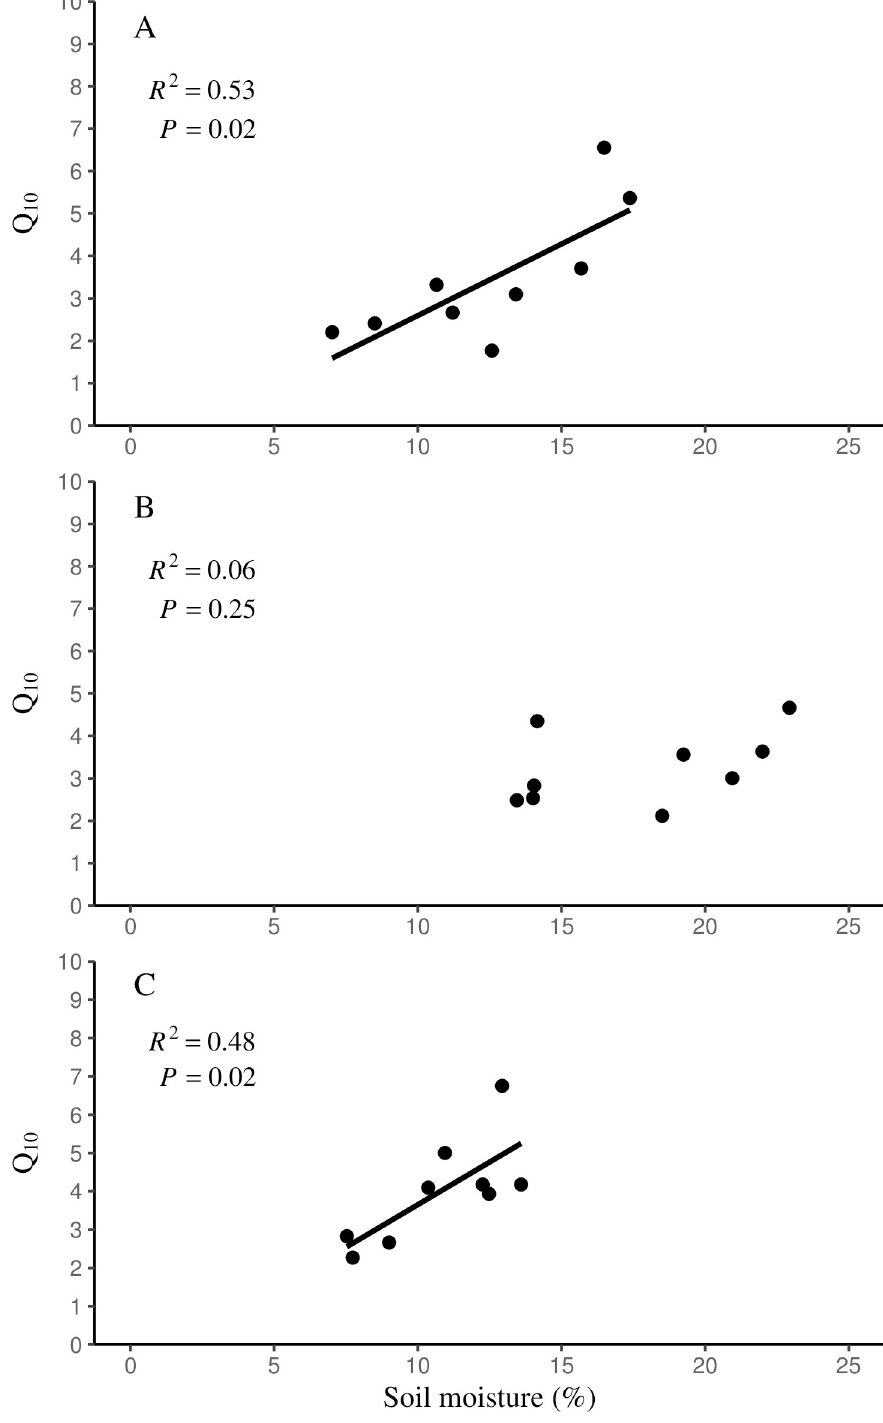
Fig 4. The relationship between Q 10 and soil moisture. The relationship between Q 10 and soil moisture (volumetric water content; VWC %) for hemlock (A), young birch (B), and mature birch stands (C) across all years.